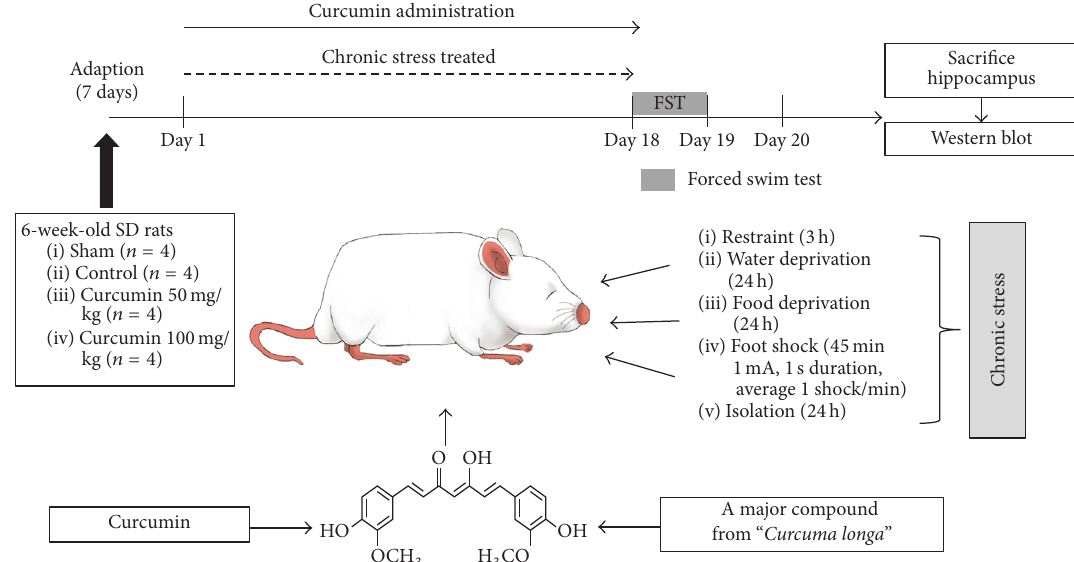
Figure 1: Experimental schedules for curcumin administration to produce an antidepressant effect in chronic stress-induced rats. The experiment was designed to explore the efficacy of curcumin against chronic stress-induced depression in an animal model using behavioral and biological methodologies. All animals were given distilled water for one week after arrival to habituate them to laboratory conditions. Starting on the first day, sham ( 𝑛 = 4 ) SD rats and control ( 𝑛 = 4 ) SD rats were fed 10 mL/kg distilled water until the end of the experiment. For the treatment groups, curcumin 50 ( 𝑛 = 4 ) SD rats were fed 50 mg/kg curcumin and curcumin 100 ( 𝑛 = 4 ) SD rats were fed 100 mg/kg curcumin. Curcumin was dissolved in DMSO. Stress was administered once a day over a period of 18 days in the control and curcumin groups. Behavioral testing commenced 60 min after the last curcumin treatment. On the last day, the rats were killed for biological